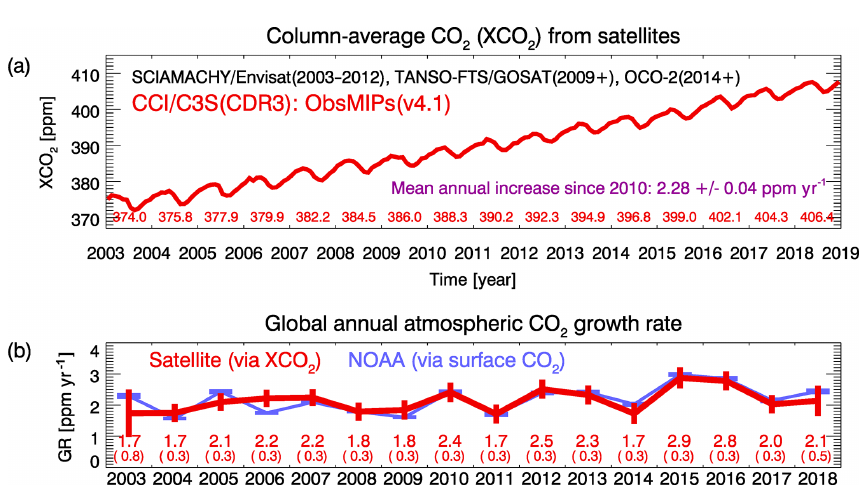
Figure 18. (a) Monthly values of the globally averaged XCO 2 (over land) as computed from the OBS4MIPS version 4.1 XCO 2 data product. The corresponding annual mean XCO 2 values are also listed. The increase during 2010–2018 is 2 . 28 ± 0 . 04ppmyr − 1 as obtained via a linear fit. (b) Annual XCO 2 growth rates (red, with 1 σ uncertainties; the corresponding numerical values are also listed with 1 σ uncertainty in brackets) and CO 2 growth rates from NOAA (shown in blue) obtained from marine surface CO 2 observations.